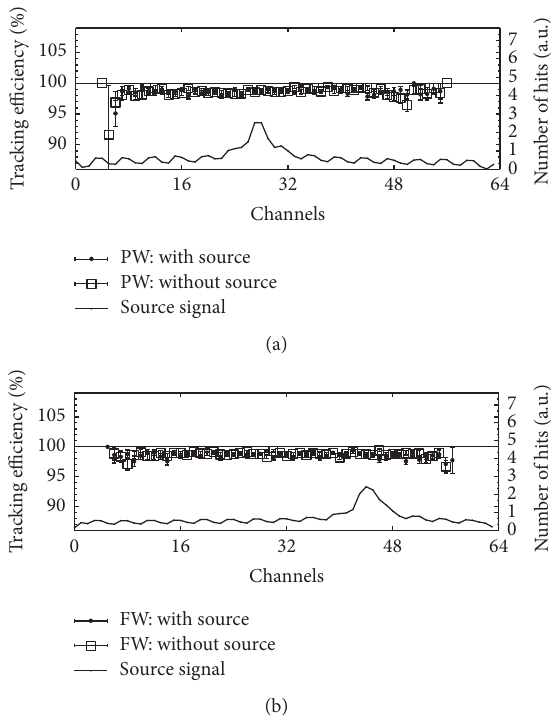
Figure 12: Tracking efficiency determined along narrow strips overlapping with the source position. No indication of an efficiency loss ((a) refers to PW; (b) refers to FW) is observed, despite the considerable (uncorrelated) increase in hit